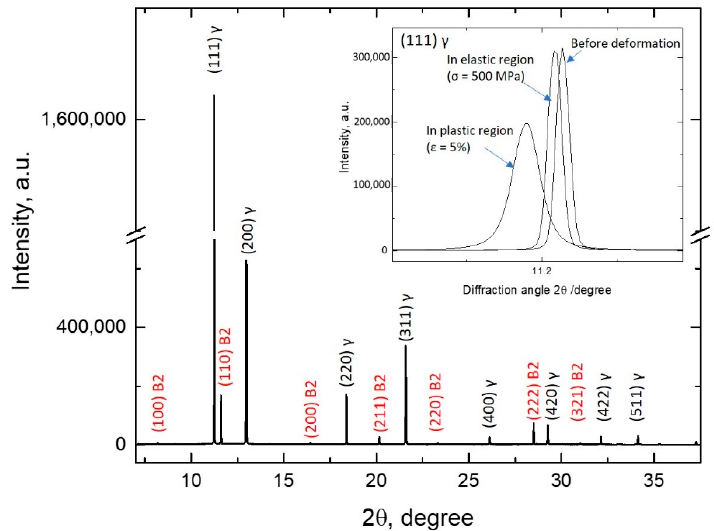
Figure 4. Nominal stress-strain curve of the UFG dual-phase Fe-20Mn-8Al-5Ni-0.8C alloy measured during the tensile test in situ XRD measurement system in SPring-8.